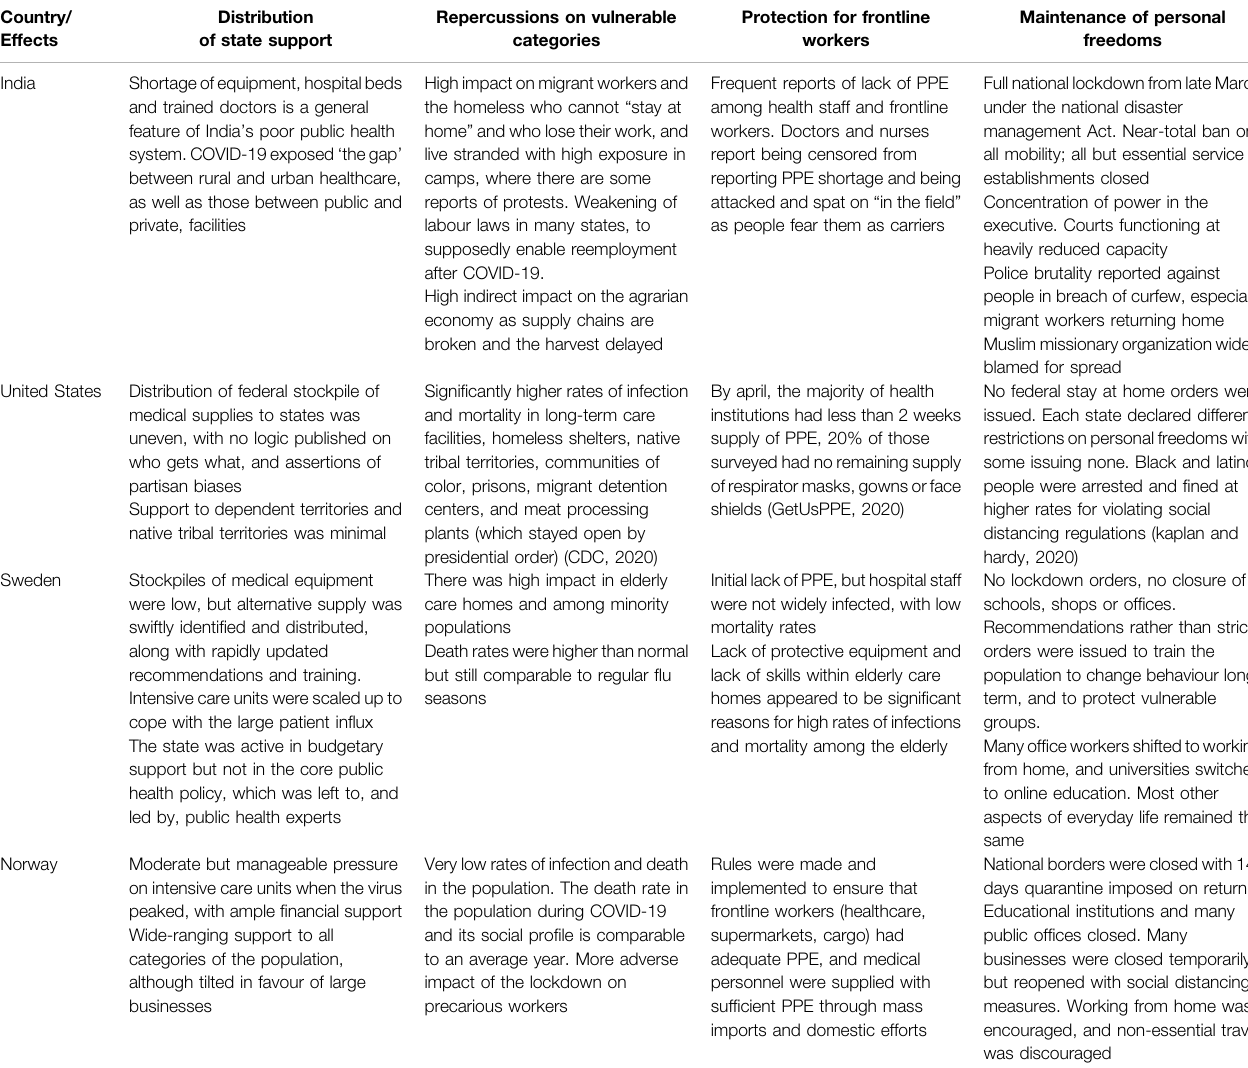
TABLE 5 | Analytical characterisations of cases by effects (sources: see Supplementary Appendix B